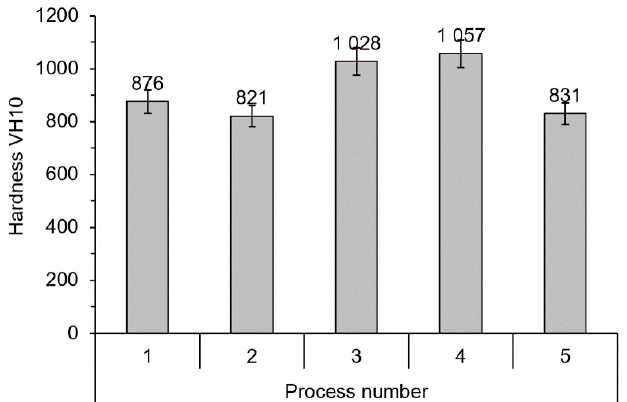
Figure 2. Results of thickness of the iron nitride layer analysis of X37CrMoV5-1 steel after low-pressure nitriding processes.